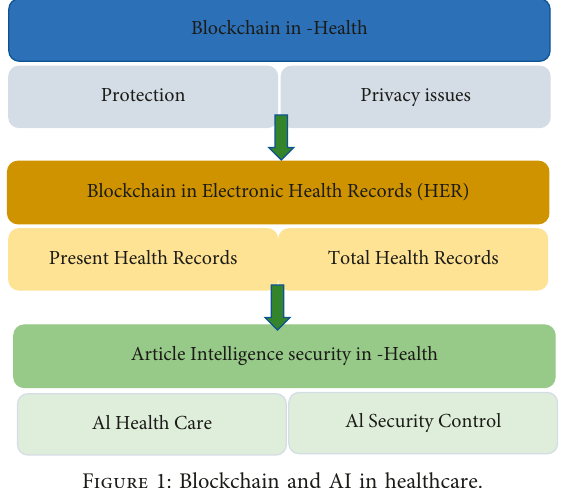
Figure 1: Blockchain and AI in